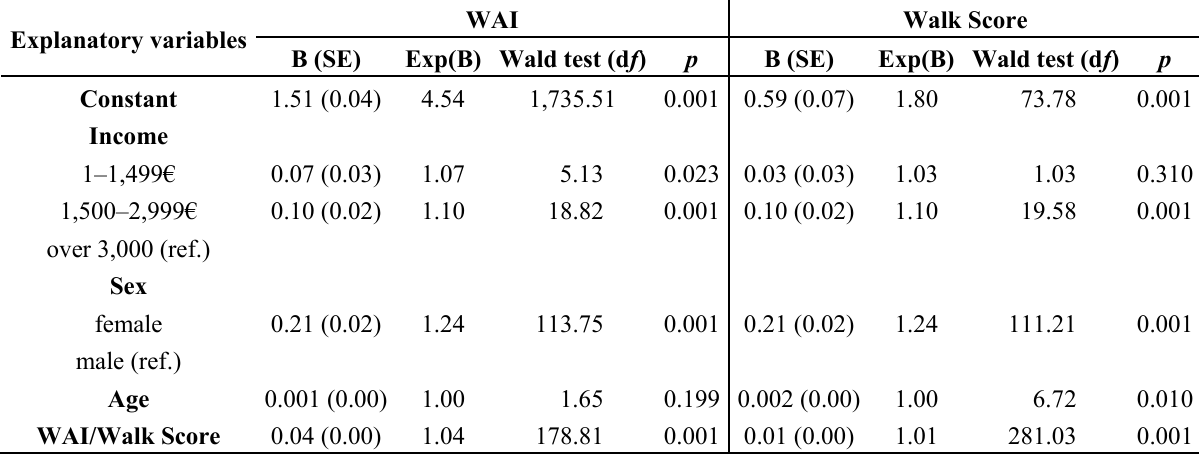
Table 5. Poisson regression models for predictors of number of walking trips per week WAI Walk Explanatory variables